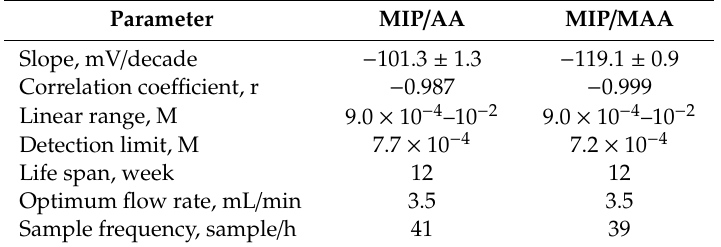
Table 3. Response characteristics of orcinol sensors using flow injection analysis in 30 mM PBS at pH 7.